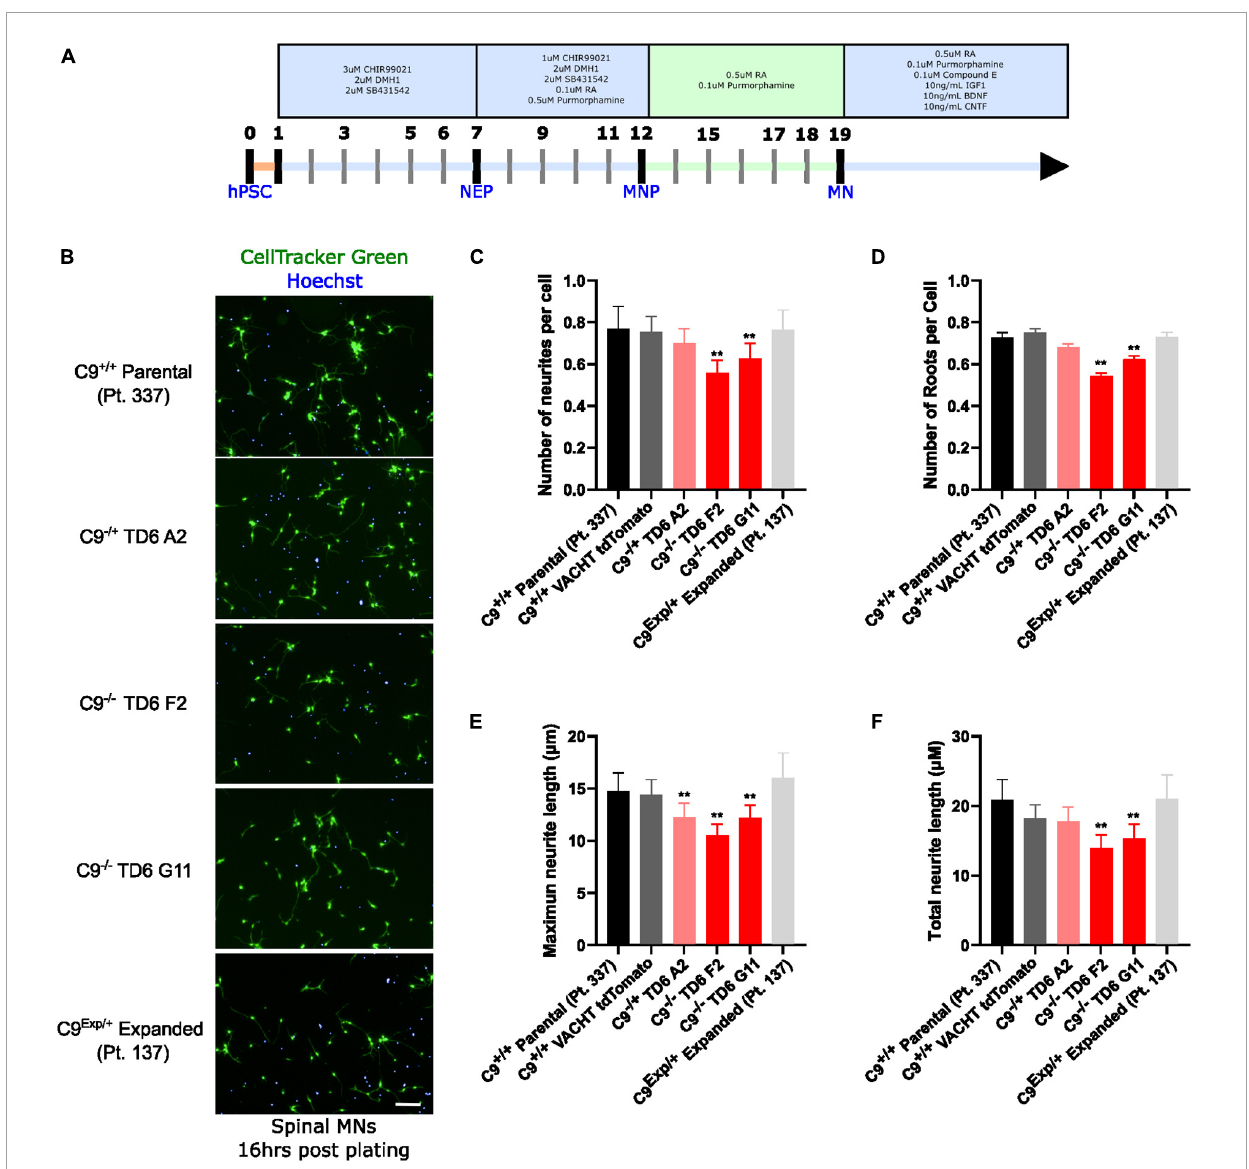
FIGURE2 Reduced C9orf72 reduces neurite outgrowth. (A) Schematic timeline for spinal motor neuron differentiation. Adapted from Du et al. (2015) (B) live-cell imaging of spinal motor neurons stained with Cell Tracker Green and Hoechst 16 h after plating. Scale bar = 100 µ m. (C) Quantification of the average number of neurite extremities per cell. (D) Quantification of the number of neurite roots per cell. (E) Quantification of the maximum neurite length per cell. (F) Quantification of total neurite length per cell. ∗∗ Denotes p < 0.01 [comparing each cell line to C9 ( + / + ) parental neurons by one-way ANOVA analysis of variance followed by Dunnett’s test]. Data are presented as mean values ± standard deviations (error